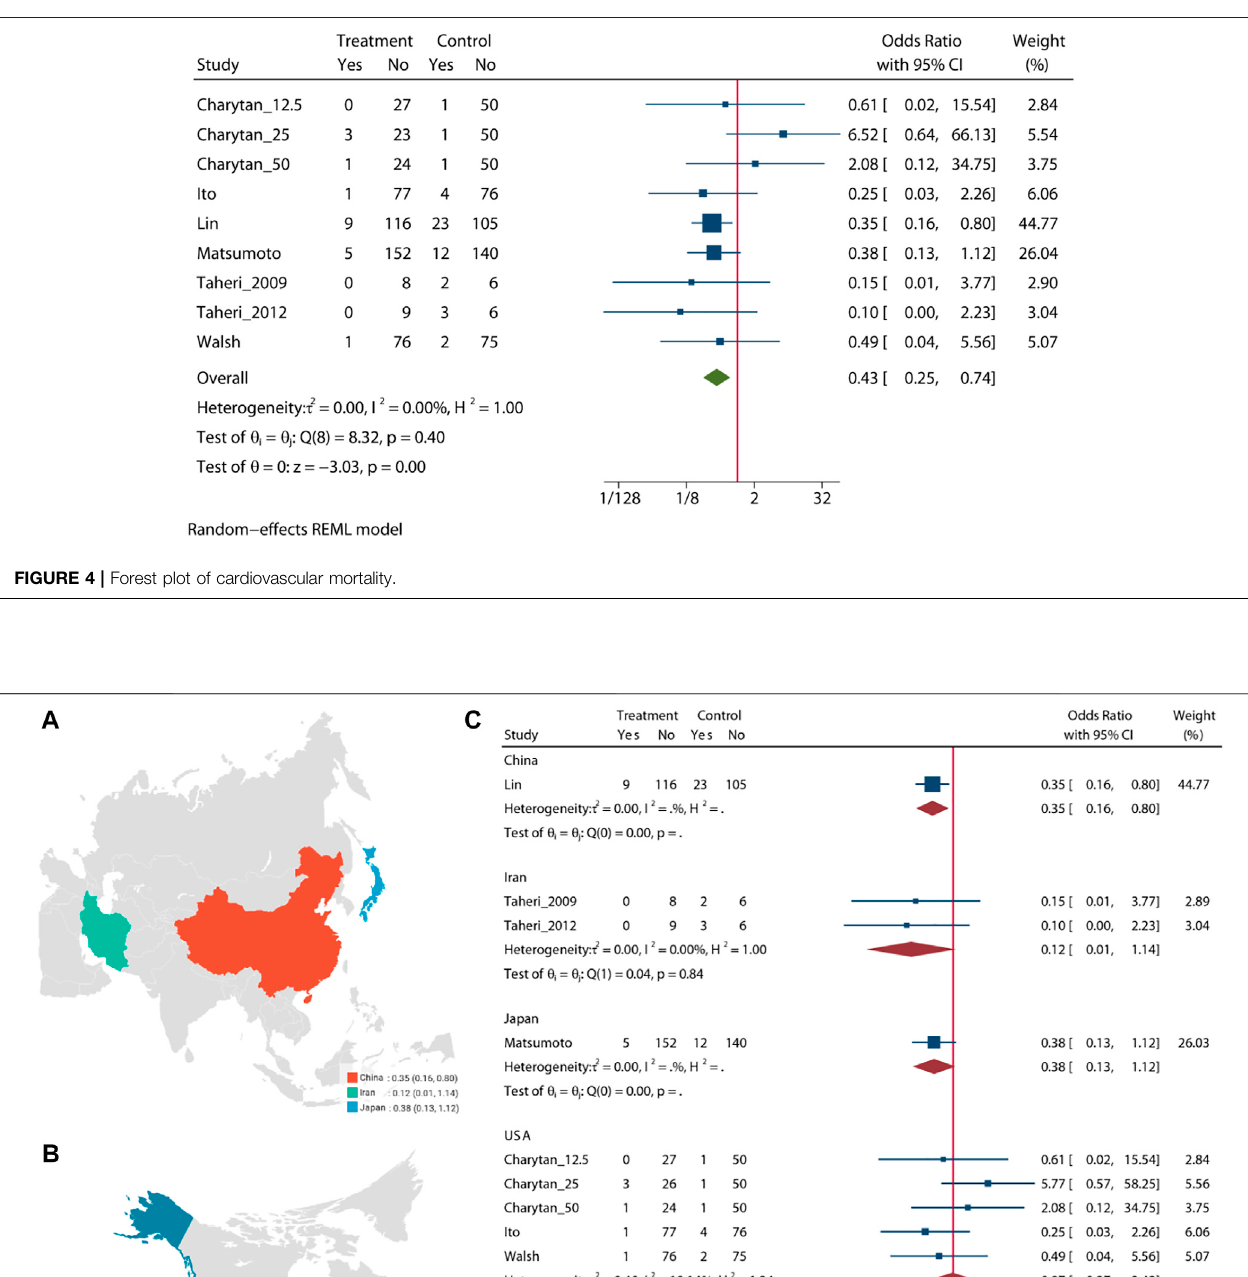
Frontiers in Pharmacology |